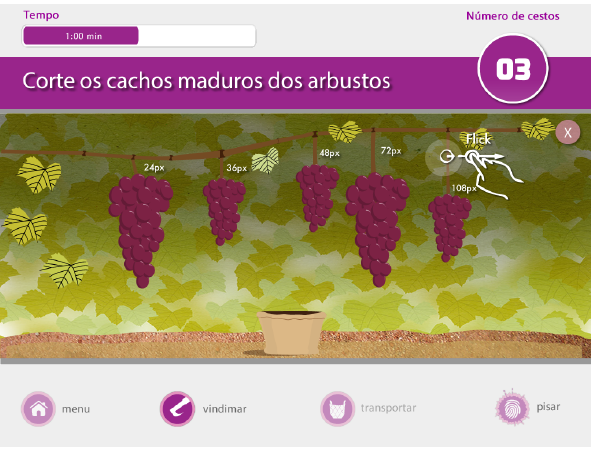
Fig. 2. Visual acuity motor skills exercised through the prototype